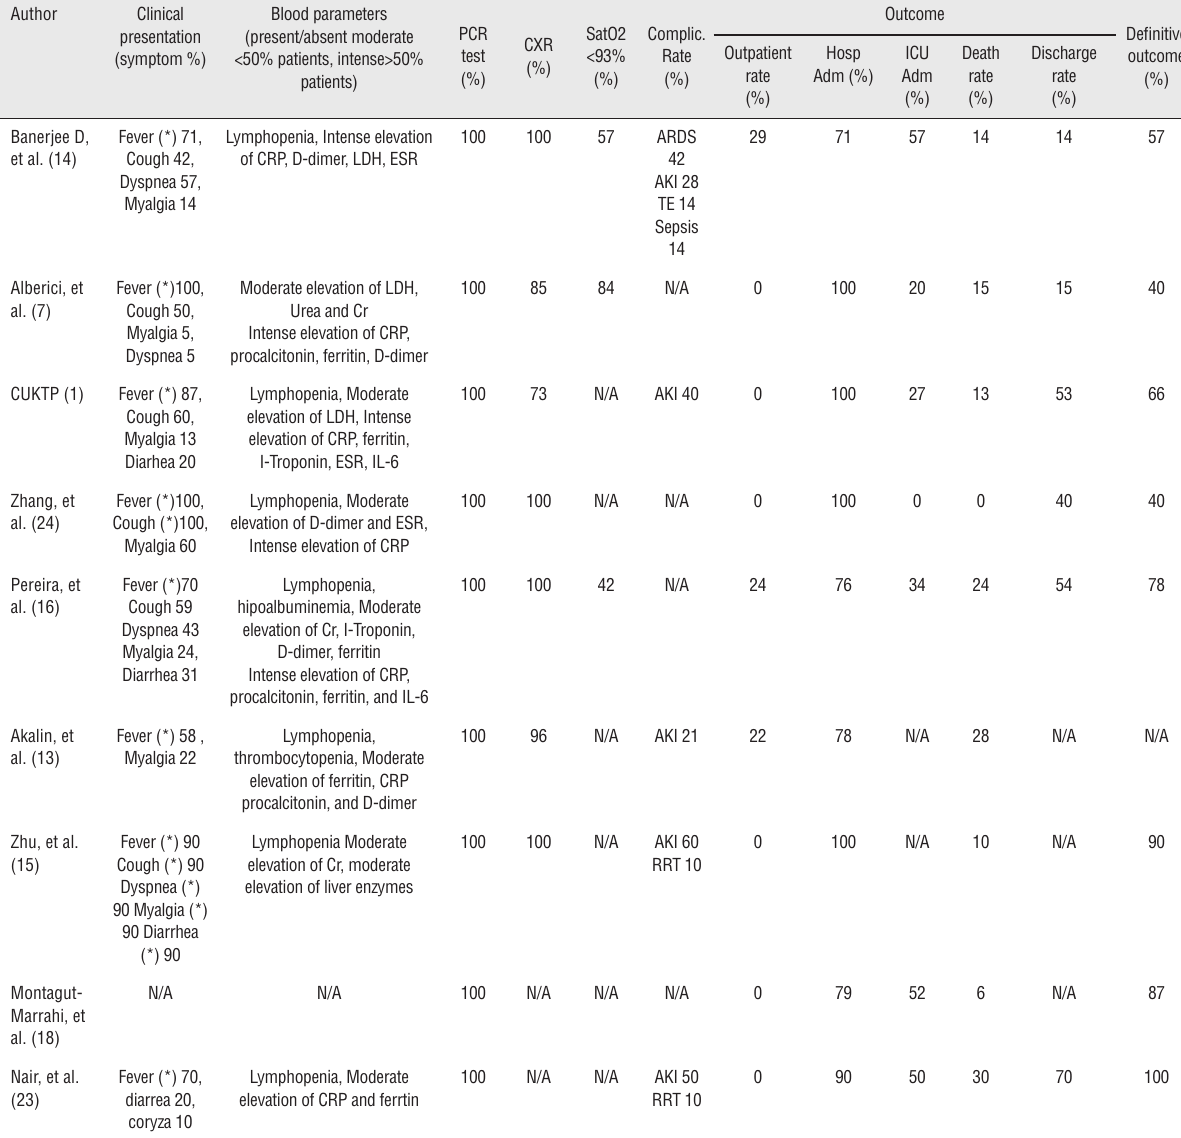
Table 2 - Summary of symptomatology, diagnostic test findings, and